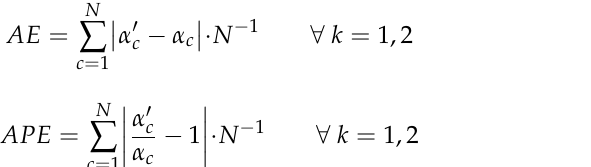
Figure 14. PMV versus PPD for different design